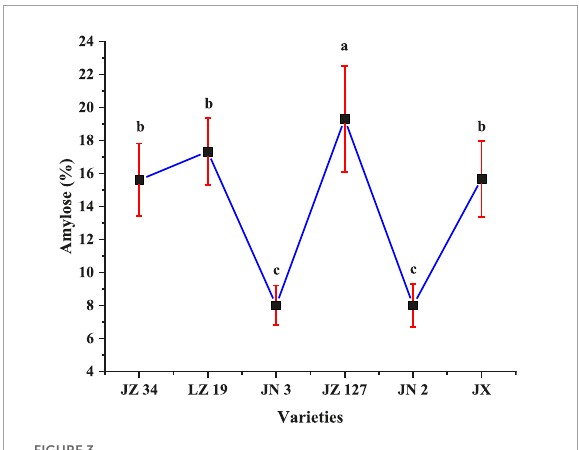
FIGURE3 Amylose content of sorghum flours. JZ 34, jinza 34; LZ 19, liaoza 19; JN 3, jinnuo 3; JZ 127, jiza 127; JN 2, jiniang 2; JX, jiaxian. The data showed the mean of three replications, and error bars are standard deviations. Different letters (a–c) indicate there were significant differences ( p < 0.05) in the LSD mean comparisons between the treatments